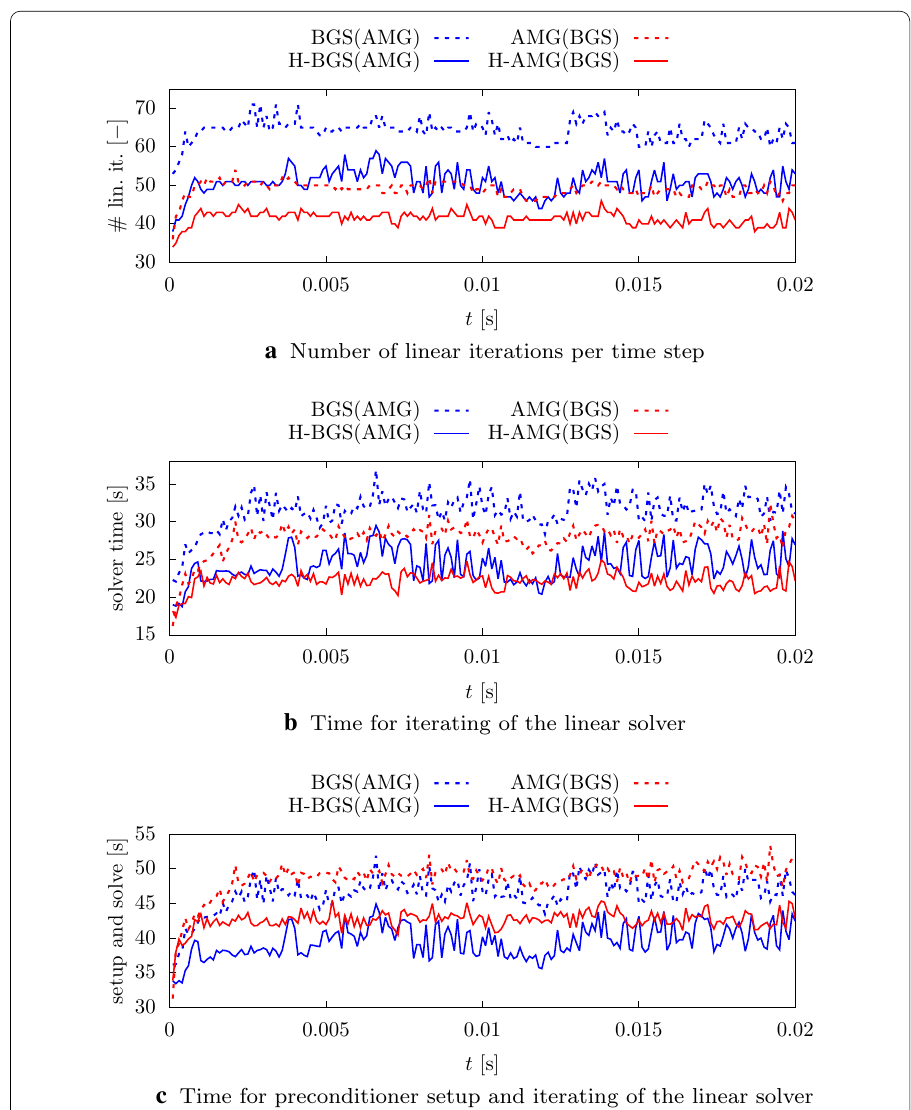
Fig. 7 Iteration counts and timings for hybrid preconditioners applied to mesh pw6 of pressure wave example on 256 parallel processes—iterations, setup and iteration timings are almost constant over all time steps. Application of the hybrid preconditioner leads to a reduction of iterations and solver time for every type of underlying physics-based block preconditioner. The additional setup cost for the hybrid preconditioner is